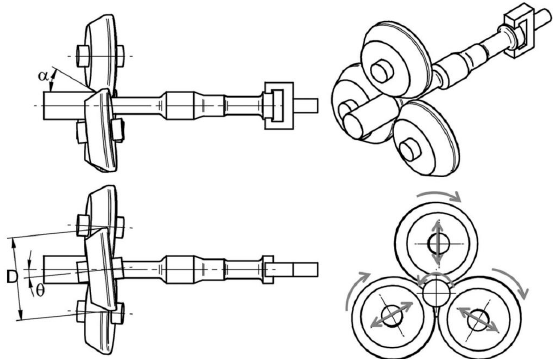
Figure 13. Design of the skew rolling process with three tapered rolls [12] (Reprinted from ref. [12]).